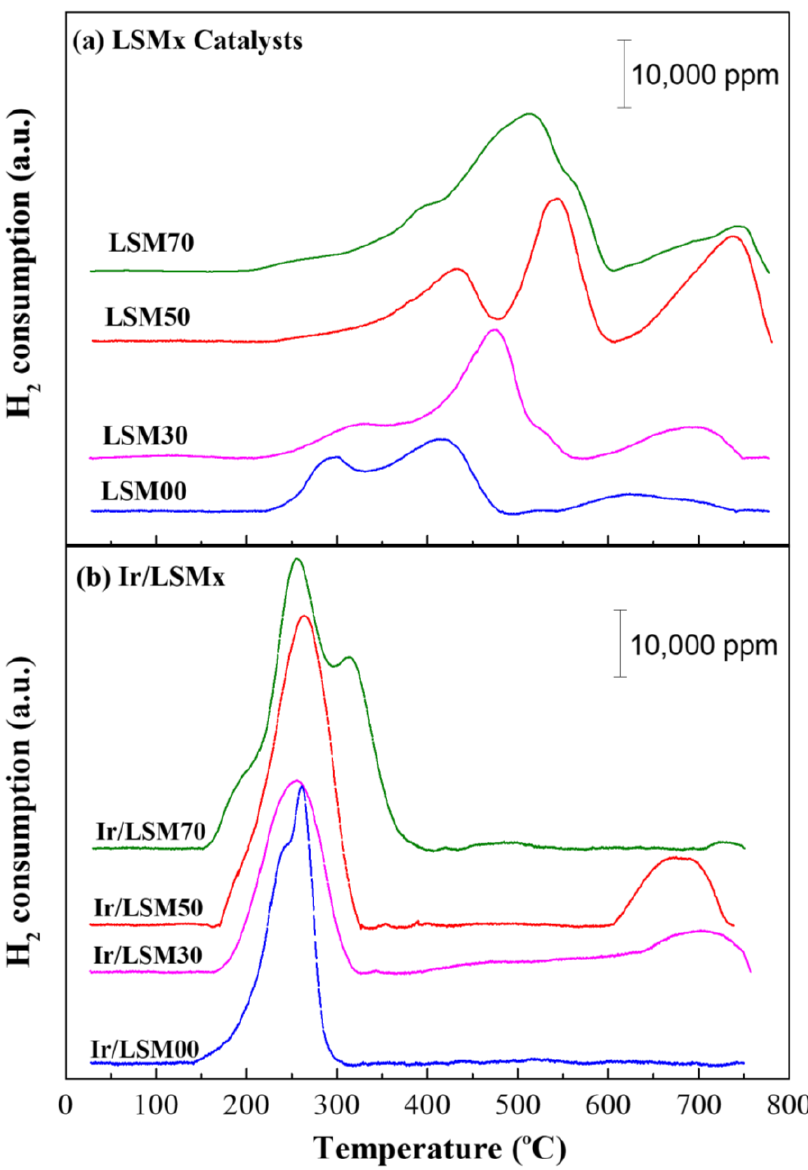
Figure 2. H 2 -TPR profiles (H 2 consumption versus temperature) of LSMx ( a ), and 2 wt% Ir/LSMx ( b )